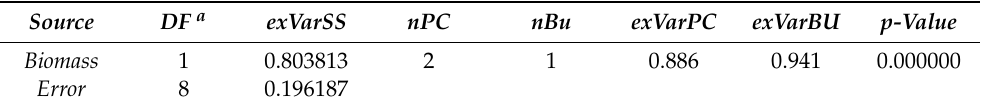
Table 6. Results of 50-50 Manova (for each biomass n ◦ = 55). Before the test, percentages were transformed into a square root of the arcsine and data standardized. aDF: Degrees of Freedom; exVarSS: explained variances based on sums of squares; nPC: number of principal components used for testing; nBu: number of principal components used as buffer components; exVarPC: variance explained by nPC components; exVarBU: variance explained by (nPC + nBU) components; p -Value: the result from 50-50 MANOVA testing. Source